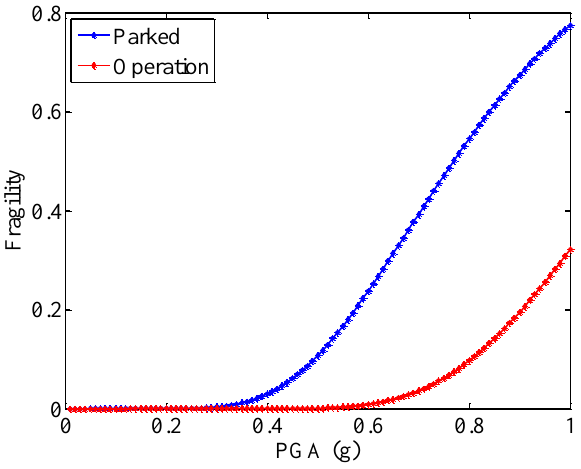
Figure 6. The fragility curves for different critical states.